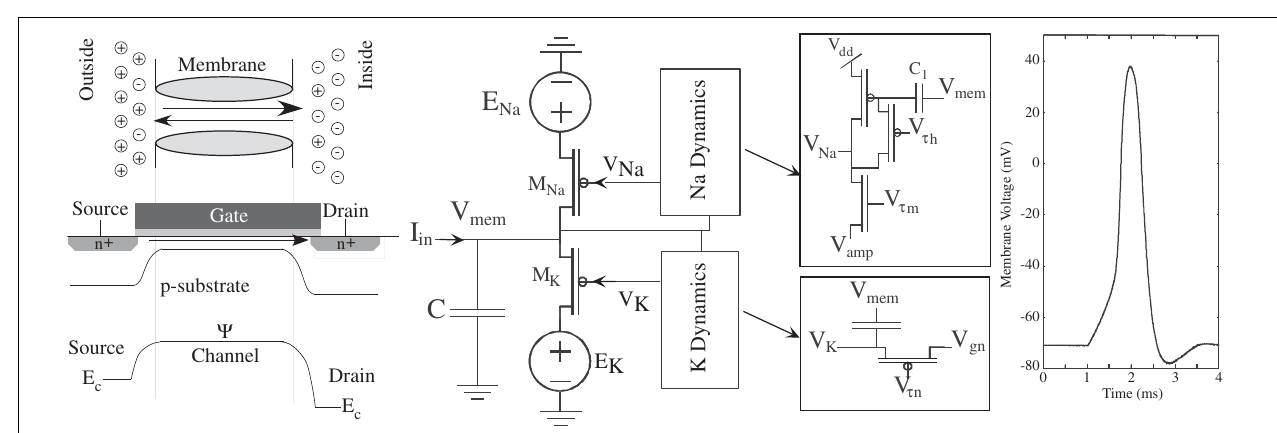
FIGURE 4 | An overview of MOSFET channel modeling of biological channels. This approach is possible given the similar (although not identical) physics between MOSFET and Biological channels both modulated by a gating potential. The physical structure of a biological channel consists of an insulating phospholipid bilayer and a protein which stretches across the barrier. The protein is the channel in this case. The physical structure of a MOSFET consists of polysilicon, silicon dioxide, and doped n-type silicon. A channel is formed between the source and